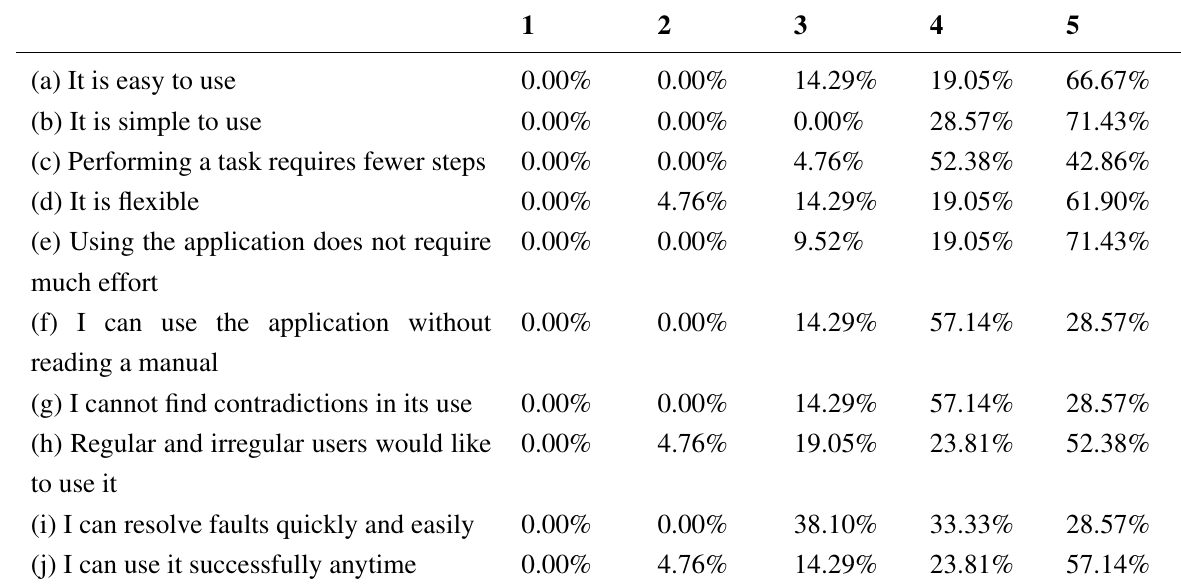
Table 4. Responses in terms of ease of